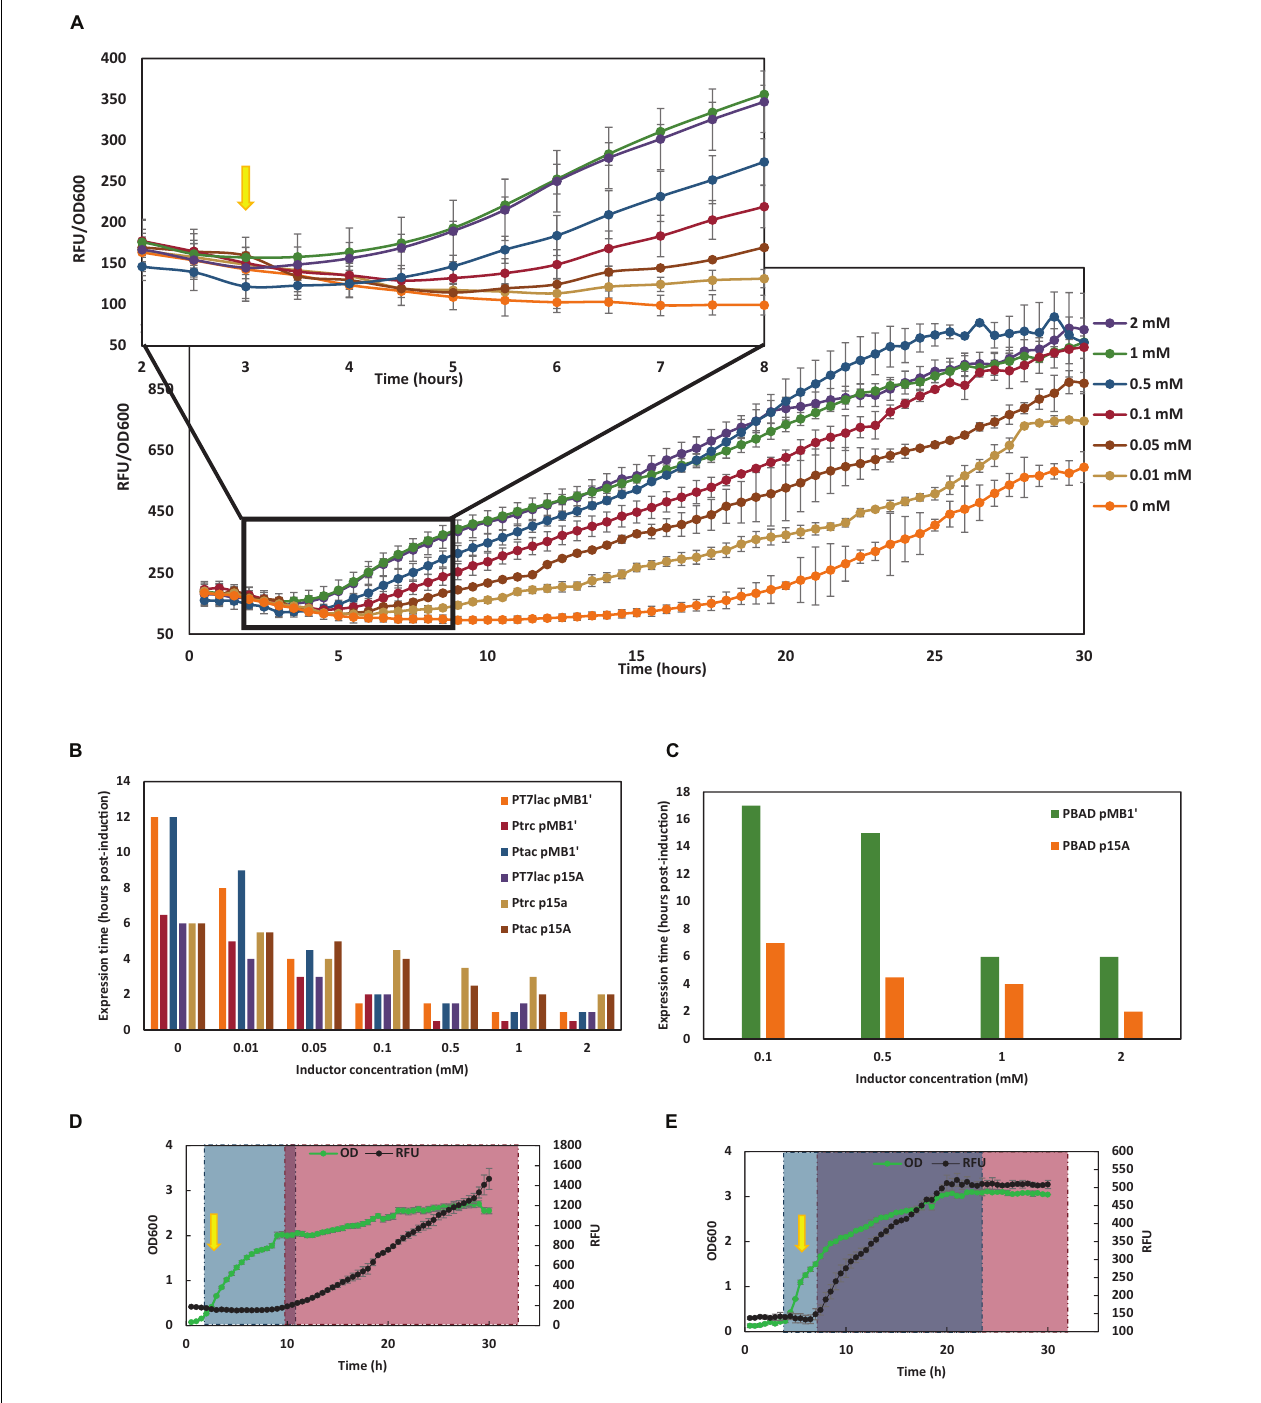
FIGURE 3 | Dependence of inductor on YFP expression time. (A) YFP expression of E. coli wt carrying the pSF-pMB1’-tac-YFP and growing with glucose as carbon source at different IPTG concentrations. Yellow arrow shows induction time with 0.1 mM IPTG. (B) YFP expression time (in hours after 0.1 mM IPTG addition) of E. coli wt carrying the different lac plasmids constructed growing in TB7 supplemented with glucose as carbon source at different IPTG concentrations. (C) YFP expression time (in hours after 2 mM L -arabinose addition) of E. coli wt carrying the P BAD plasmids constructed growing in TB7 supplemented with glucose as carbon source at different L -arabinose concentrations. (D) E. coli wt carrying pSF-pMB1 (cid:48) -BAD-YFP growing with glucose as carbon source. (E) E. coli wt carrying pSF-pMB1 (cid:48) -BAD-YFP growing with glycerol as carbon source. Green dots show grown at 600 nm, while black dots show YFP fluorescence in arbitrary units (RFU). Gray square corresponds with culture growth, and pink square indicates YFP expression. Purple square indicates hours when culture is growing and expressing YFP simultaneously. Yellow arrow shows 2 mM L -arabinose induction time.